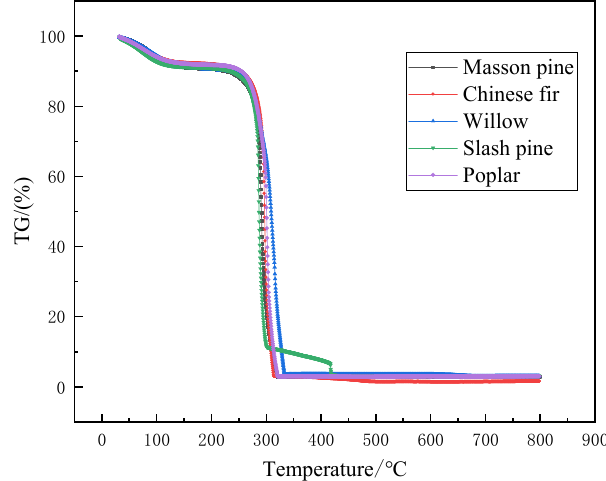
Figure 1. TG curves of five kinds of biomass pellet fuel.